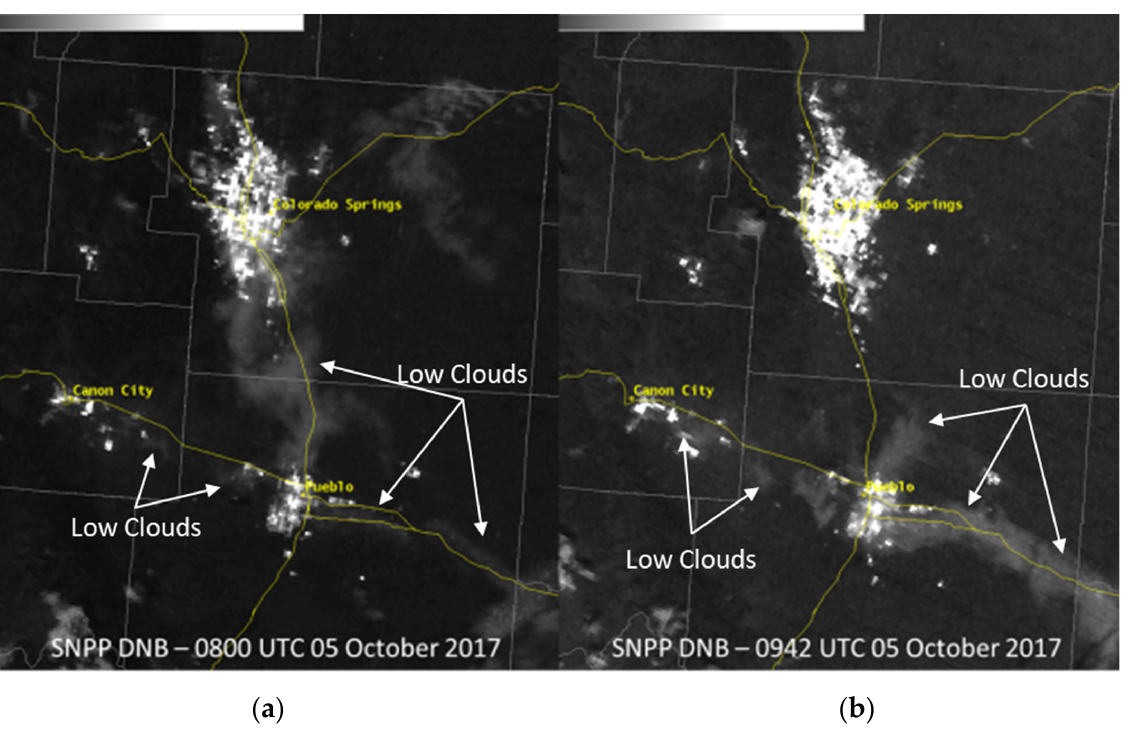
Figure 5. Fog along the Arkansas River valley as observed by the NCC product from VIIRS, 0800 ( a ) and 0942 ( b ) UTC, 5 October 2017. The Arkansas River extends from WNW to ESE from west of Canon City, through Canon City and Pueblo, and east of Pueblo. The gray lines are county boundaries and the yellow lines are interstates. Gray scale colormap represents NCC puesdo-reflectance values from low as black to high as white. Adapted from: https://satelliteliai- sonblog.com/2017/10/05/using-suomi-npp-viirs-dnb-to-track-fog/, accessed on 7 February 2023.